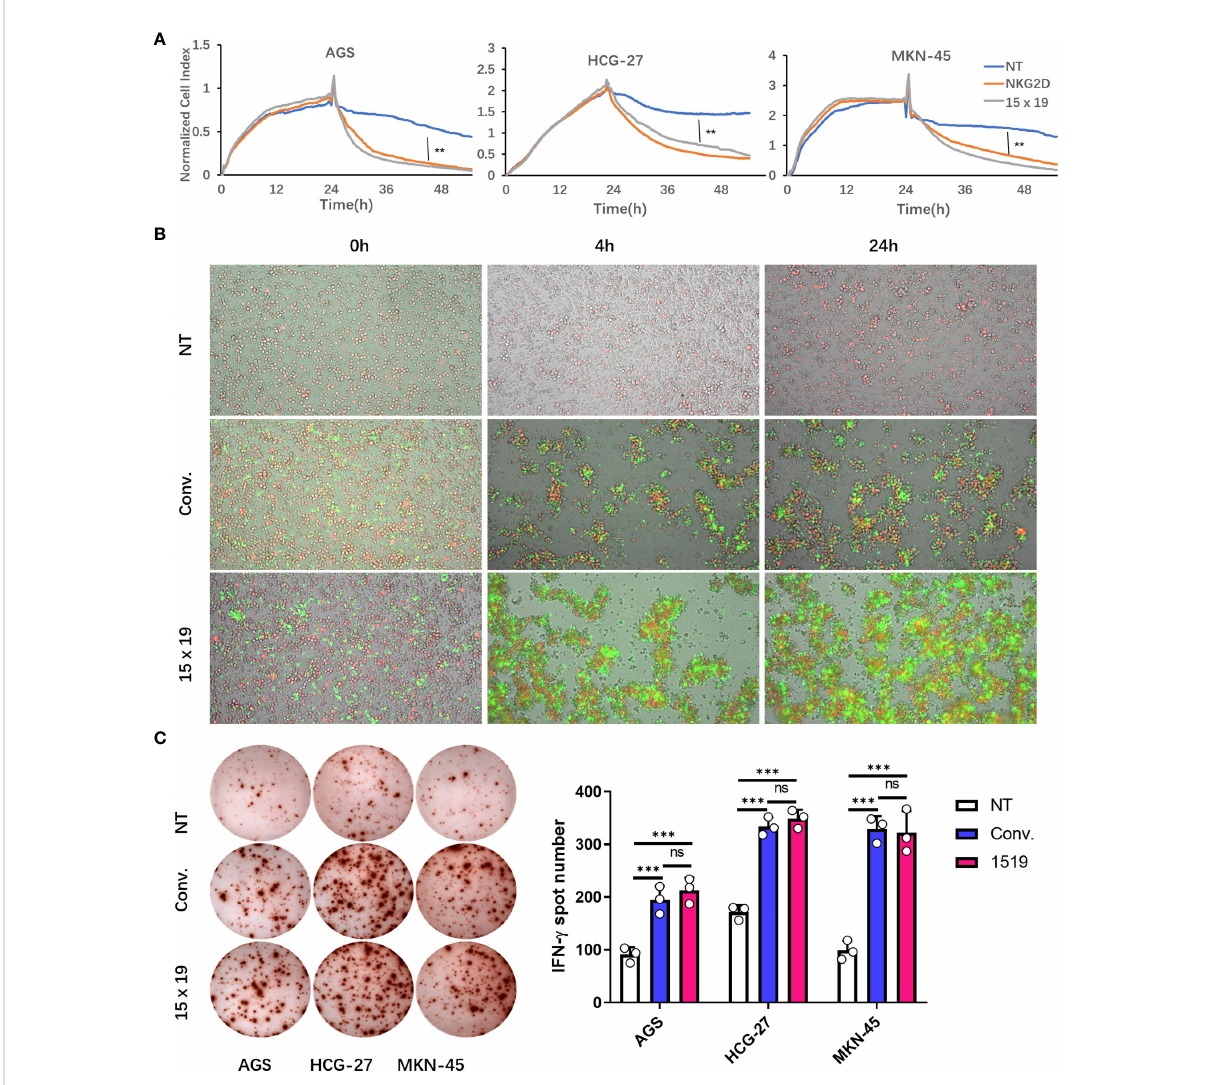
FIGURE 5 15 × 19 CAR T cells enhance cytotoxicity and IFN- g production. (A) , The cell index values are recorded following co-culture of cells in the NT, conventional CAR and 15 × 19 CAR groups with gastric cancer cells at a ratio of 1:1 for 24 hours using the xCELLigence system. Gastric cancer cells are more effectively killed within 24 hours in the conventional CAR and 15 × 19 CAR groups than in the NT group ( P < 0.01), while no signi fi cant difference was seen between conventional CAR and 15 × 19 CAR groups ( P > 0.05); (B) , Dynamic changes in the fl uorescent intensity following co-culture of cells in the NT, conventional CAR and 15 × 19 CAR groups with gastric cancer cells at a ratio of 1:1 at 0, 4 and 24 hours. There are plenty of gastric cancer cells (red fl uorescence) adherent to the plate wall 24 hour post-incubation in the NT group, while gastric cancer cells (red fl uorescence) are almost completely killed in the conventional CAR and 15 × 19 CAR groups within 4 hours post-incubation, together with the expansion of effector cells. A higher degree of expansion of 15 × 19 CAR T cells (green fl uorescence) is observed than that of conventional CAR T cells; (C) , ELISPOT assay shows lower numbers of IFN- g spot-forming cells in the NT group than in conventional CAR and 15 × 19 CAR groups ( P < 0.001), while no signi fi cant difference was seen between conventional CAR and 15 × 19 CAR groups ( P > 0.05). Analyzed for statistical signi fi cance by one-way ANOVA with multiple comparisons test. ns , no signi fi cant difference; ** P < 0.01; *** P <